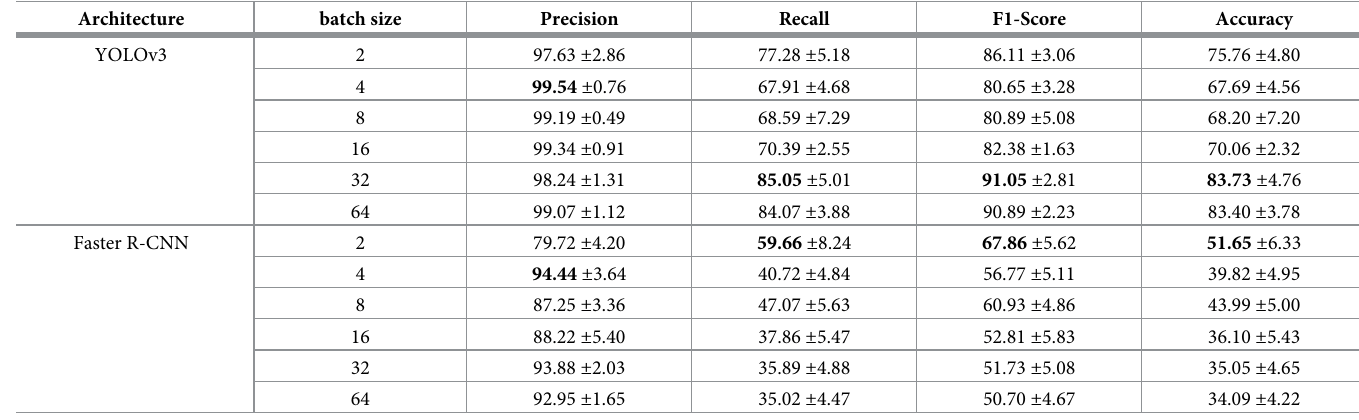
Bold font indicates the best results obtained by each